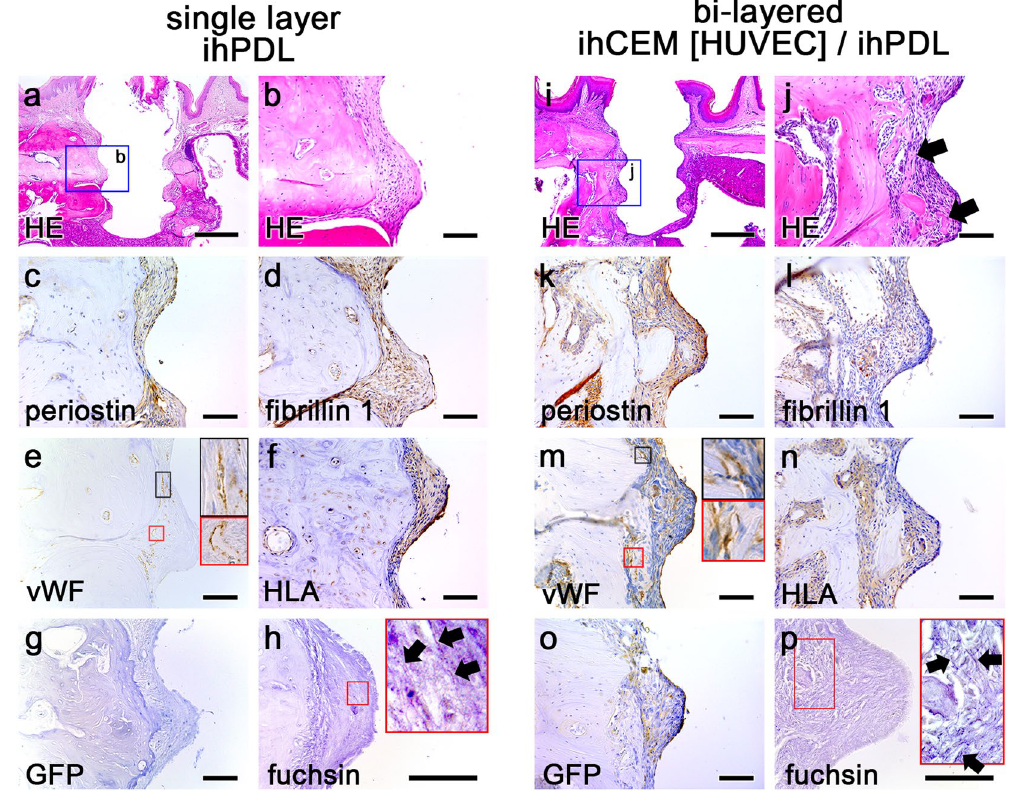
Figure 2. Periodontium-like tissue formation by transplanted cell sheets. ( a ) HE-stained image at 8 weeks after ihPDLs sheet transplantation. PDL-like connective tissue is observed between the fixture and the alveolar bone. ( b ) High magnification of panel a. The alignment of the PDL-like tissue is parallel to the fixture. ( c , d ) IHC of the PDL markers, periostin and fibrillin 1. The periostin and fibrillin 1 staining was positive around the PDL-like tissue. ( e ) IHC of the blood vessel marker, vWF. Blood vessels were observed in the alveolar bone and PDL-like tissue. ( f ) IHC of HLA. The PDL-like tissue showed a strong HLA signal, and the signal was also observed in some areas of the alveolar bone. ( g ) IHC of GFP. In the ihPDLs sheet transplantation, GFP was not detected. ( h ) Resorcin-fuchsin staining. Arrows show the oxytalan fibres in the PDL-like connective tissue. ( i ) HE-stained image at 8 weeks after ihCEM [HUVEC]/ihPDL bi-layered cell sheet transplantation. ( j ) High magnification of panel g. The arrows indicate remodelled bone. The alignment of the fibrous tissue is perpendicular to the fixture. ( k , l ) IHC of periostin and fibrillin 1. Positive periostin and fibrillin 1 signalling were detected in the PDL-like tissue. ( m ) IHC of vWF. Blood vessels were observed around the remodelled bone and in the PDL-like tissue. ( n ) IHC of HLA. The PDL-like tissue shows positive HLA signalling. ( o ) IHC of GFP. This shows blood vessels in the PDL-like tissue originated from the GFP tagged HUVECs. ( p ) Resorcin-fuchsin staining. Arrows indicate the oxytalan fibres in the PDL-like tissue. Scale bars, ( a , i ) 500 μ m; ( b – h , j – p ) 100 μ